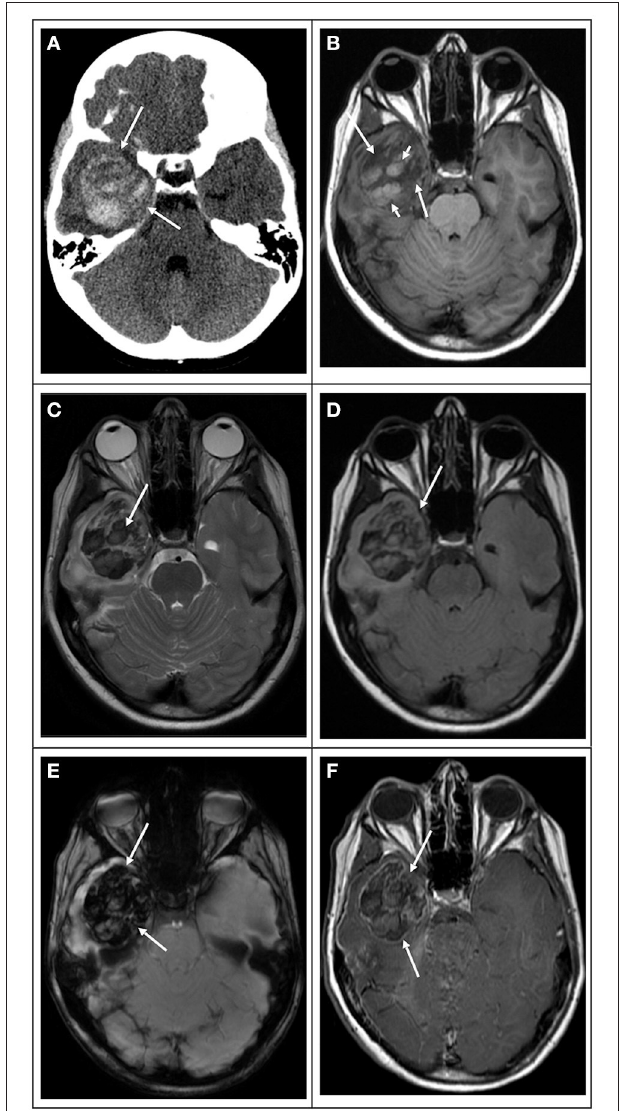
FIGURE 8 | 10-year-old male with worsening headaches and papilledema due to a right temporal lobe “glioblastoma”. (A) Computed tomography image in the axial plane shows a heterogeneously hyperdense area in the right temporal lobe in keeping with a diffusely hemorrhagic lesion. At this point, the differential includes vascular lesions or tumors. (B) T1 weighted image in the axial plane shows that the lesion is heterogeneous with mixed signals. The tumoral bed is hypointense (white arrows) with scattered hyperintensity components due to intratumoral hemorrhage (white arrowheads). (C) T2 weighted image and (D) FLAIR images in the axial plane show that the bulk of the lesion is hypointense due to diffuse intratumoral hemorrhage. (E) Susceptibility weighted image in the axial plane shows extensive signal drop within the tumoral bed (white arrows) in keeping with diffuse hemorrhage. (F) T1-weighted contrast-enhanced image in the axial plane shows that the tumor enhances heterogeneously. The mass has thin peripheral enhancement (arrowhead) with internal variable minimal enhancement due to hemorrhage and